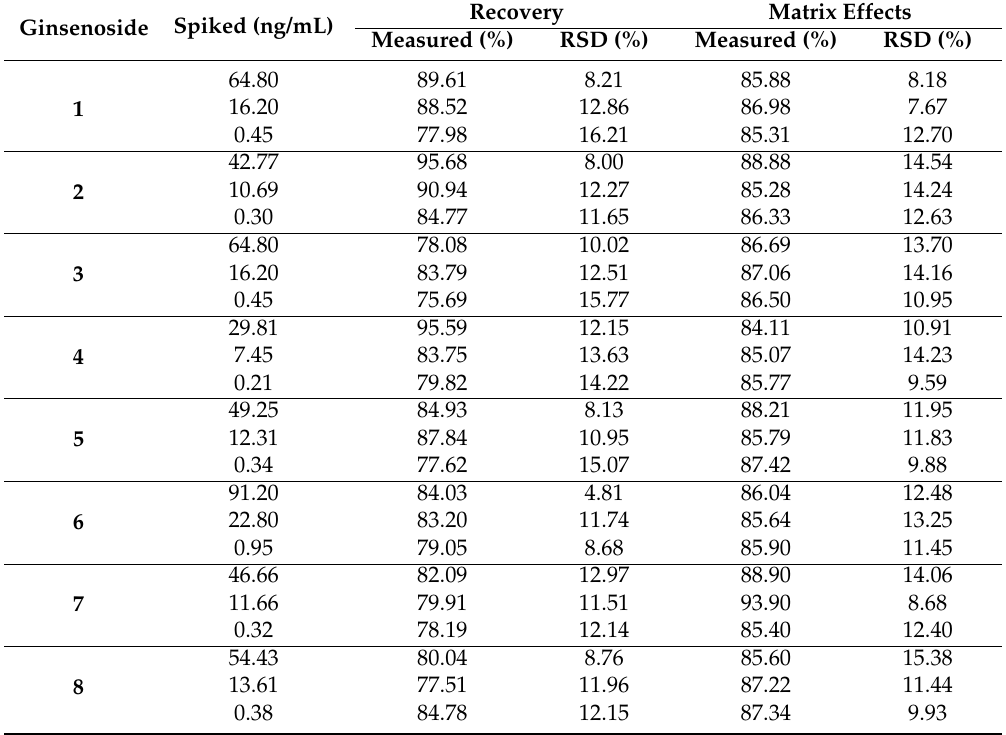
Table 2. Extraction recovery and matrix effects of eight